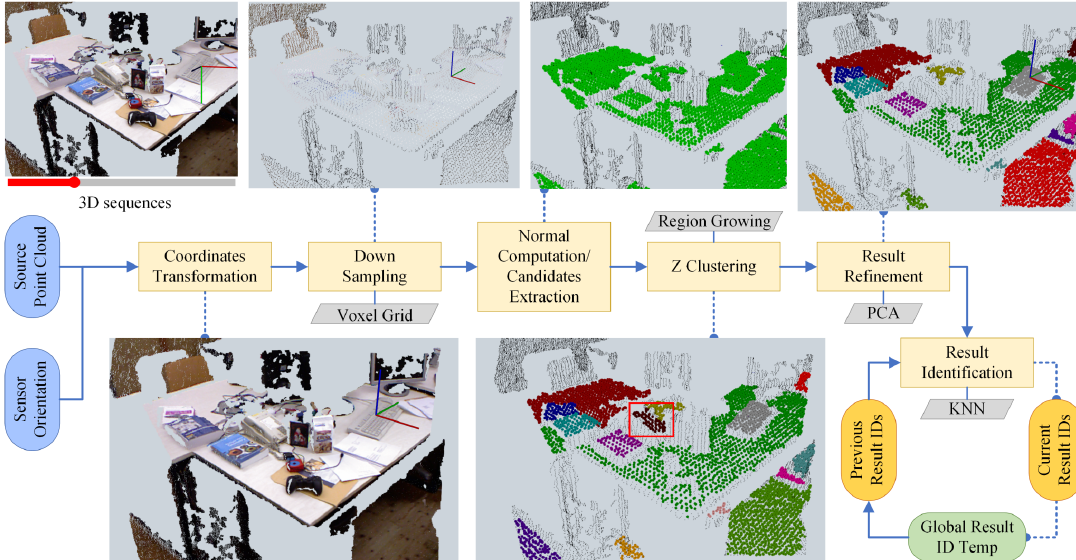
Figure 2. The architecture of the horizontal plane extraction pipeline along with the resulting screenshot of each procedure. The framework takes as input each point cloud in the 3D sequence and sensor orientation corresponding with that, which go through subsequential processing components. Please note that in the lower middle subfigure the area marked with red box indicated a slant surface of a telephone, which should not be included in the final results representing horizontal planes and was successfully filtered out by the result refinement method, as shown in the upper right subfigure. Best viewed in online color